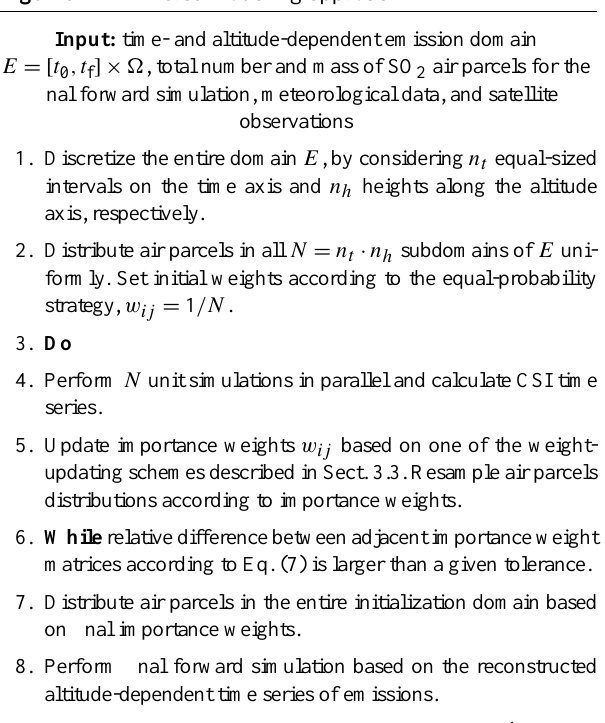
Algorithm 1 Inverse modeling